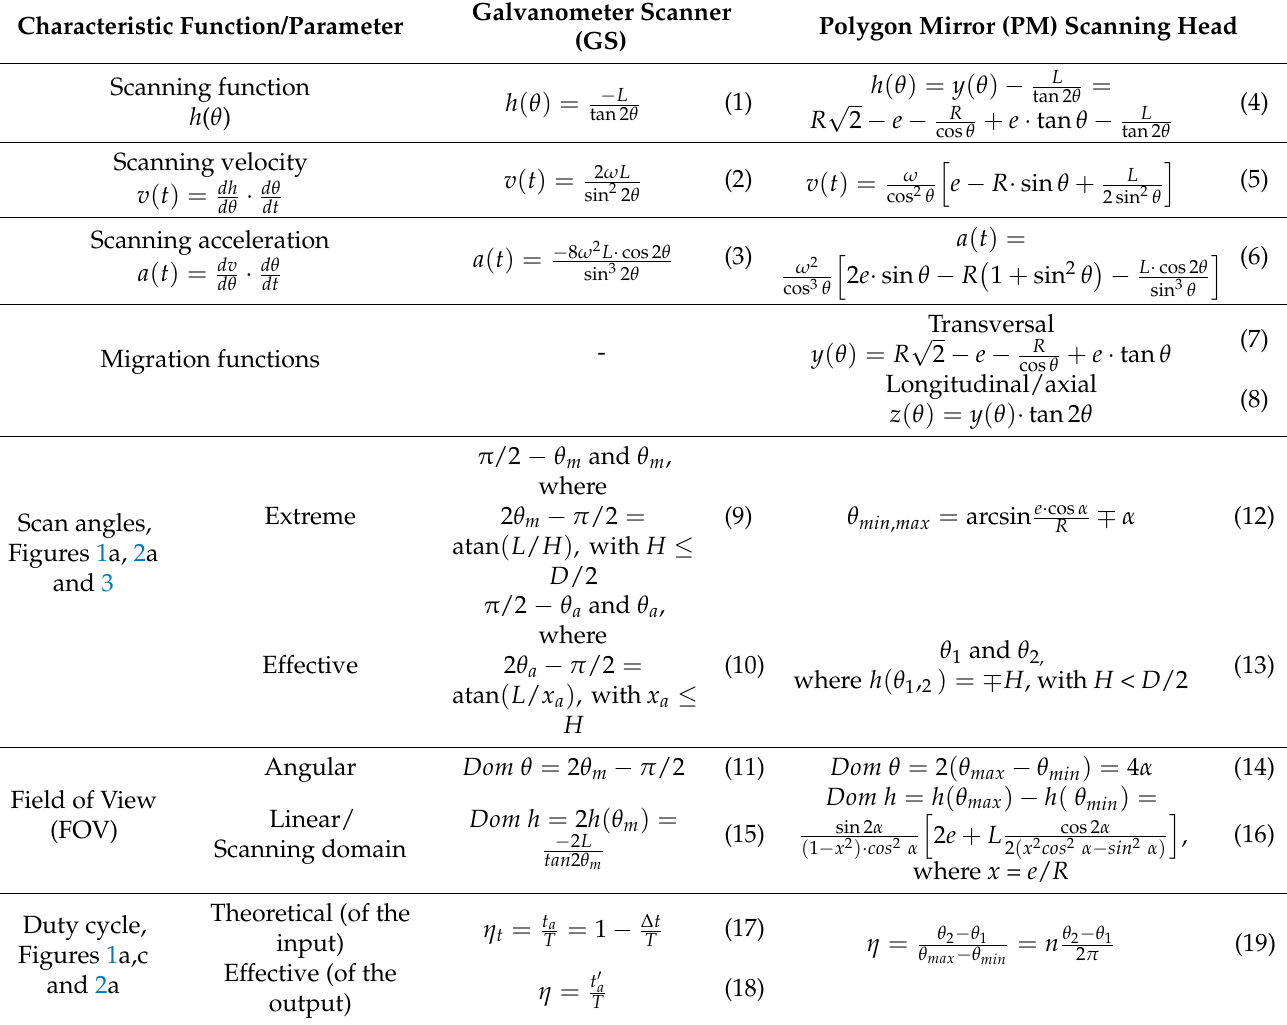
Table 1. Overview of characteristic functions and parameters of GSs versus PM scanning